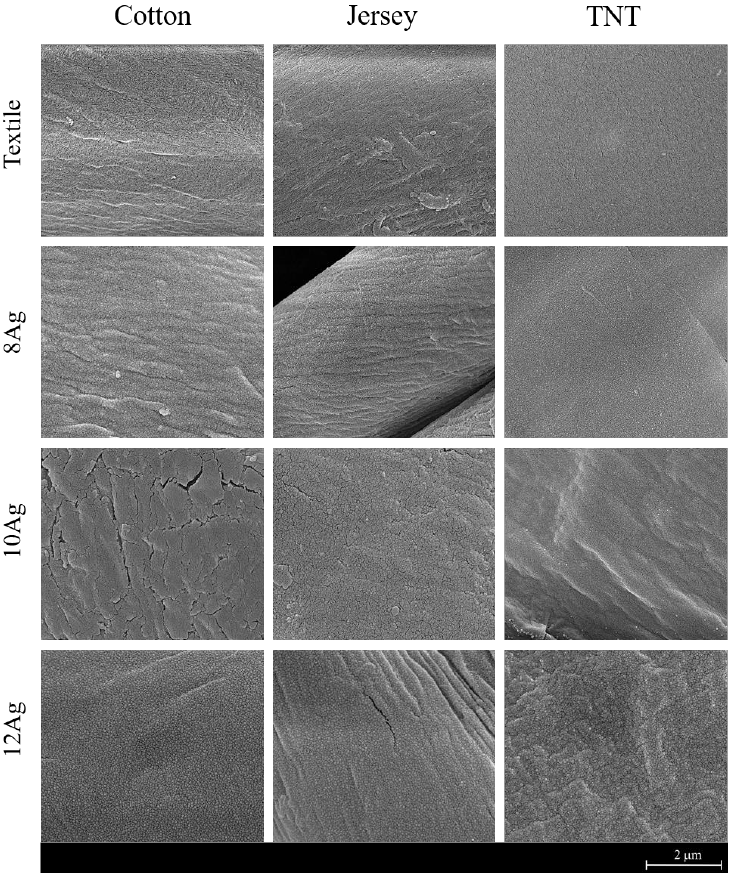
Figure 1. SEM images of the coated and uncoated substrates at a magnification of 50 kx, acquired at 10 kV.